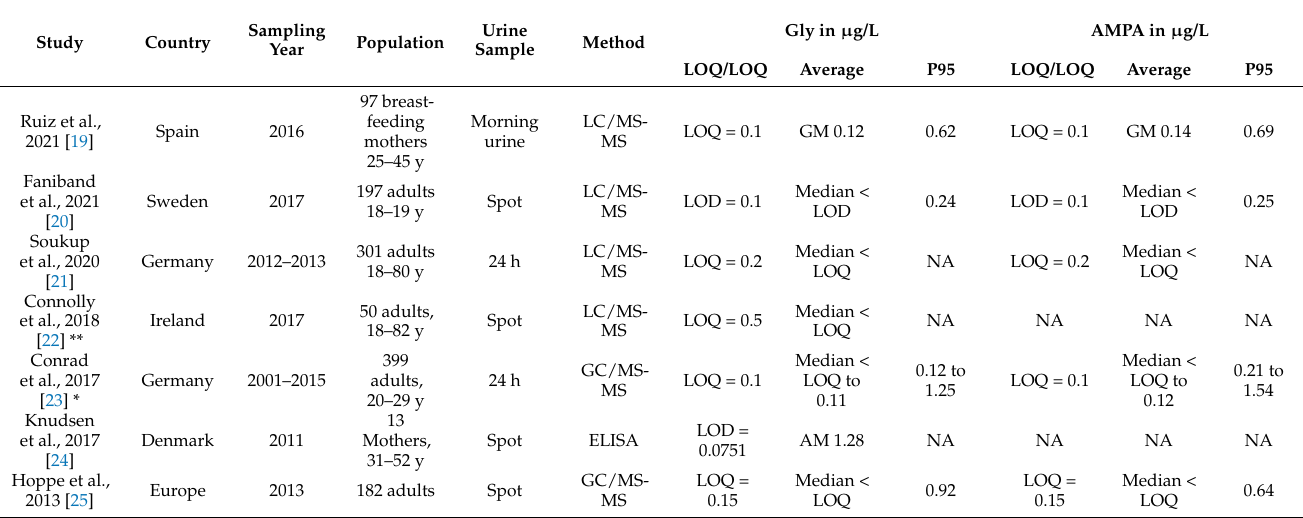
Table 3. Comparison with published European exposure data on urinary glyphosate (Gly) and AMPA concentrations in EU adults from the general